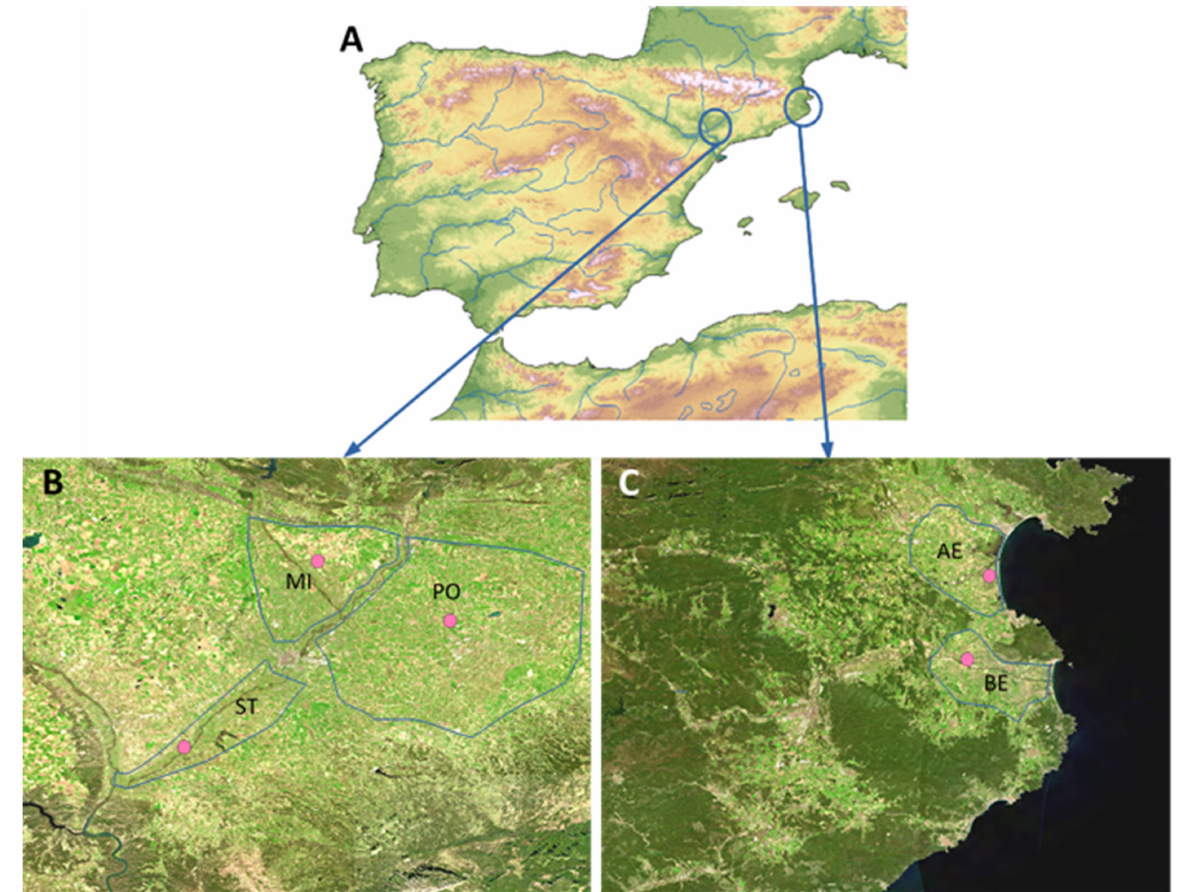
Figure 1. ( A ) Map of Spain showing the location of the two provinces of the north-east, ( B ) Lleida and ( C ) Girona, hosting the five fruit-growing areas studied: Girona: AE: Alt Empord à (pome fruit-growing area), BE: Baix Empord à (pome fruit-growing area), and Lleida: ST: Stone fruit-growing area, MI: Mixed stone and pome fruit-growing area and PO: Pome fruit-growing area. The locations of the official weather stations are indicated with pink